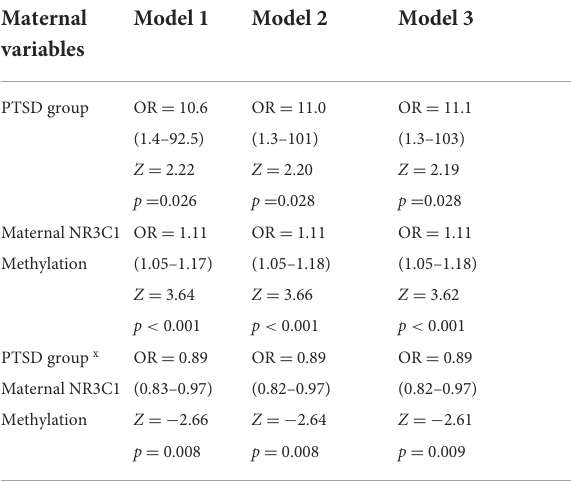
TABLE 1 Ordinal logistic regression models for child methylation of the NR3C1 gene across CpGs as the dependent